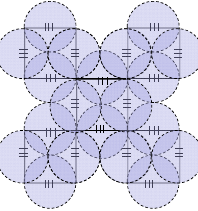
Figure 10. Coverage of SSC group